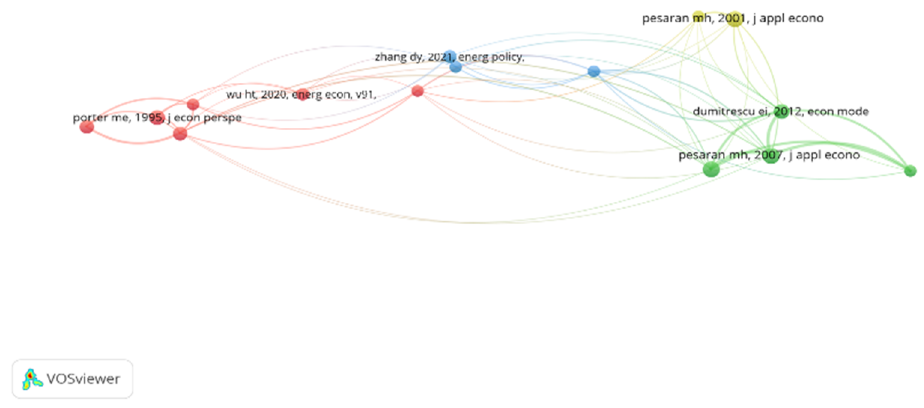
Figure 5. Co ‐ citation of references map. Figure 5. Co-citation of references